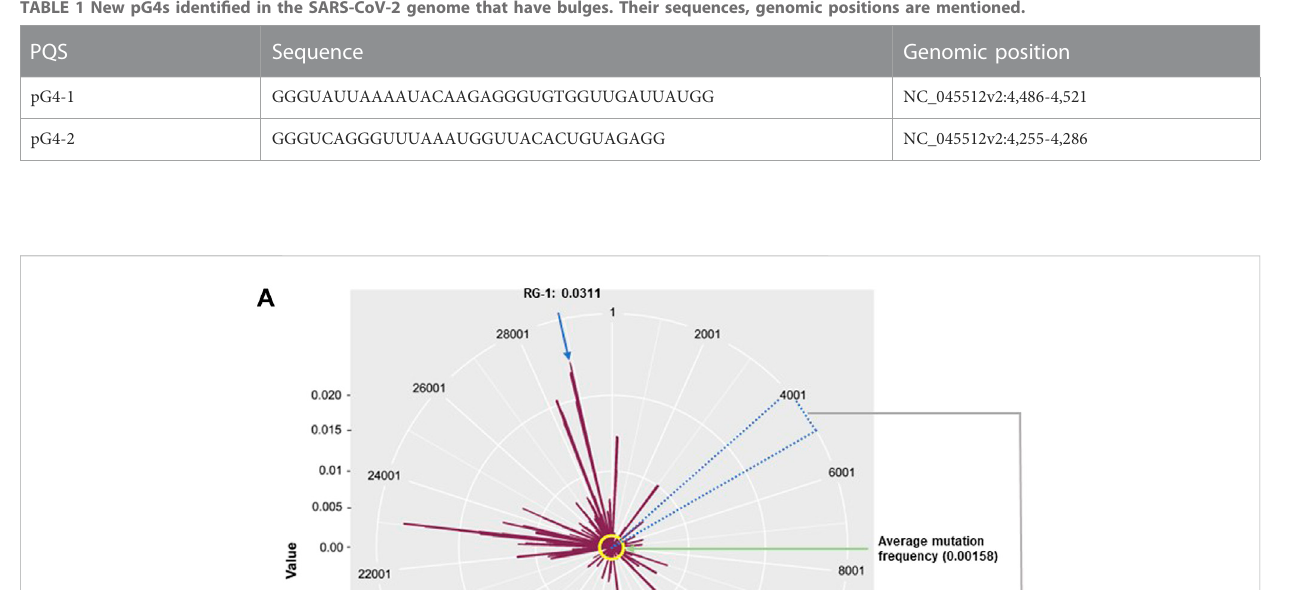
dissociation constants in the micromolar range: The binding whereas PCZ binds to pG4-1 in a biphasic manner